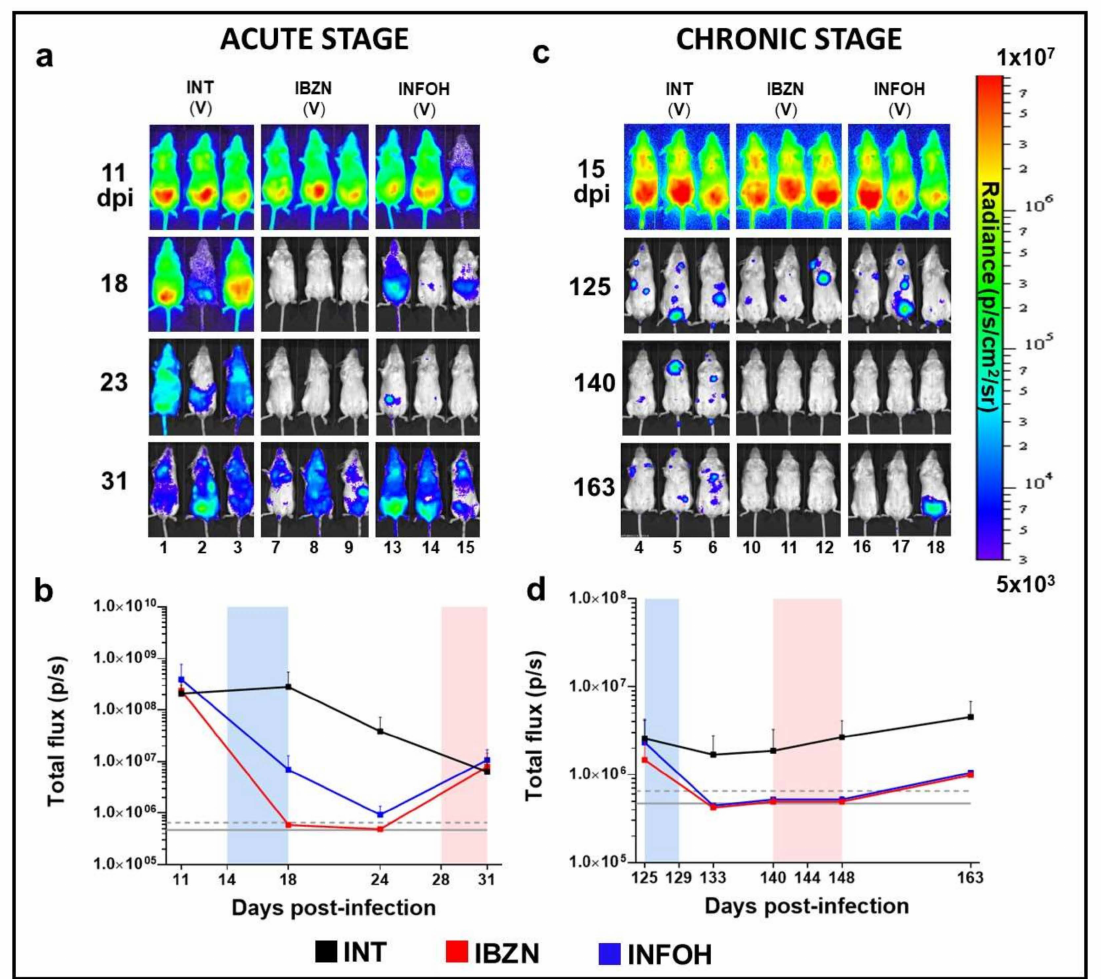
Figure 3. In vivo assessment of NFOH against acute ( a , b ) and chronic ( c , d ) stage T. cruzi infections. BALB/c mice were treated with NFOH or BZN at 100 mg kg − 1 for 5 days (Materials and Methods) starting at 14 (acute) or 125 (chronic) days post-infection (dpi). ( a , c ) Representative ventral images of BALB/c mice acquired at various points dpi, as indicated. INT, infected non-treated (vehicle only); IBZN, infected treated with BZN; INFOH, infected treated with NFOH ( n = 6 for acute and n = 12 for chronic stage infections). ( b , d ) Quantification of whole animal bioluminescence during the acute ( b ) and chronic ( d ) phase of infection (mean bioluminescence ± SEM) from all treated or non-treated mice. Grey horizontal solid line indicates mean background bioluminescence; dashed horizontal grey line indicates +2 SD (naïve mice, n = 4). Heat-maps are on log 10 scales and indicate intensity of bioluminescence from low (blue) to high (red). Blue bar indicates five-day treatment period ( b , d ). All BZN- and NFOH-treated mice were immunosuppressed using cyclophosphamide during the period indicated by the pink bar ( b , d ) (Material and